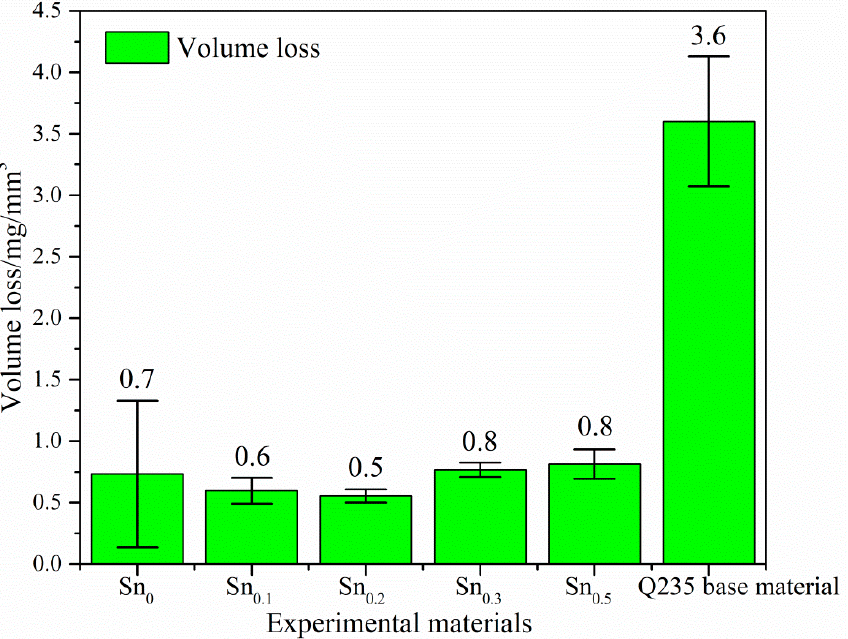
Figure 11. Volume losses of CoCrFeNiMnSn x HEAs coating and Q235 base material due to wear.